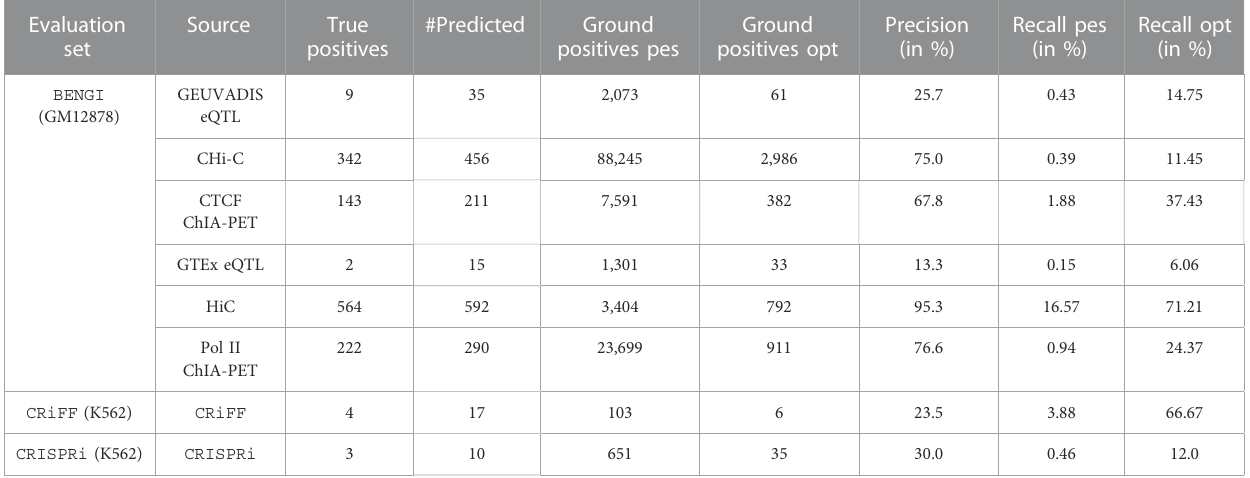
TABLE 2 TargetFinder ’ sperformances on BENGI , CRiFF and CRISPRi . #Predicted refersto the number of positive (TP +FP)and negative (TN +FN)predictions that were also in the reference set, and is used to compute Precision. Groundpositives pes. refers to the total number of ground positive elements in the reference set, while Ground Positives opt. refers to the subset of those that were also in the set of E/G relationships TargetFinder started from. Recall pes. and Recall opt. are computed from Ground Positives pes. and Ground Positives opt. respectively, therefore corresponding to pessimistic and optimistic estimations of recall